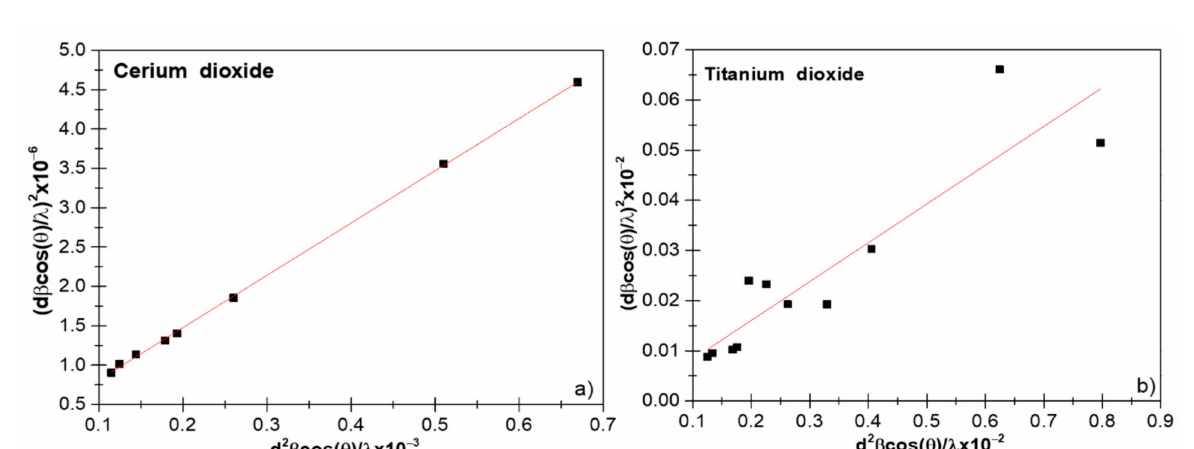
Figure 3. The size–strain plot (SSP) of CeO 2 ( a ) and TiO 2 NPs ( b ). The SSP is one of the methods that consider the XRD peak profile to be a combination of the Lorentzian and the Gaussian functions. Under this assumption, the ε profile is reflected by the Gaussian function and the size of the crystallites by the Lorentz